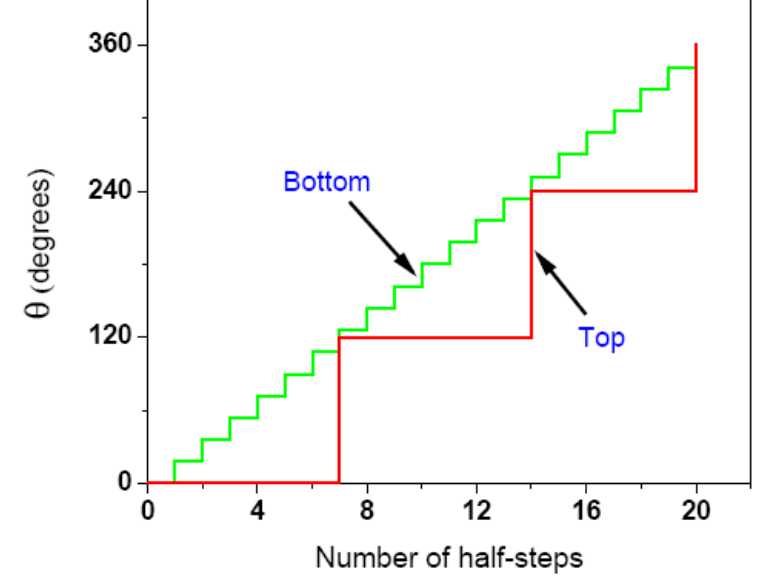
Figure 1. Torsional mechanism for F The diagram is drawn for a ring of ten c-subunits (i.e., n=10) and half-steps of 360 o /(2n). A symmetry mismatch between c and γ rotation of 6 o after 120 o , and 12 o after 240 o [for half-steps of 360 o /(2n)] is found. After 360 o , it is found that the symmetry mismatch becomes